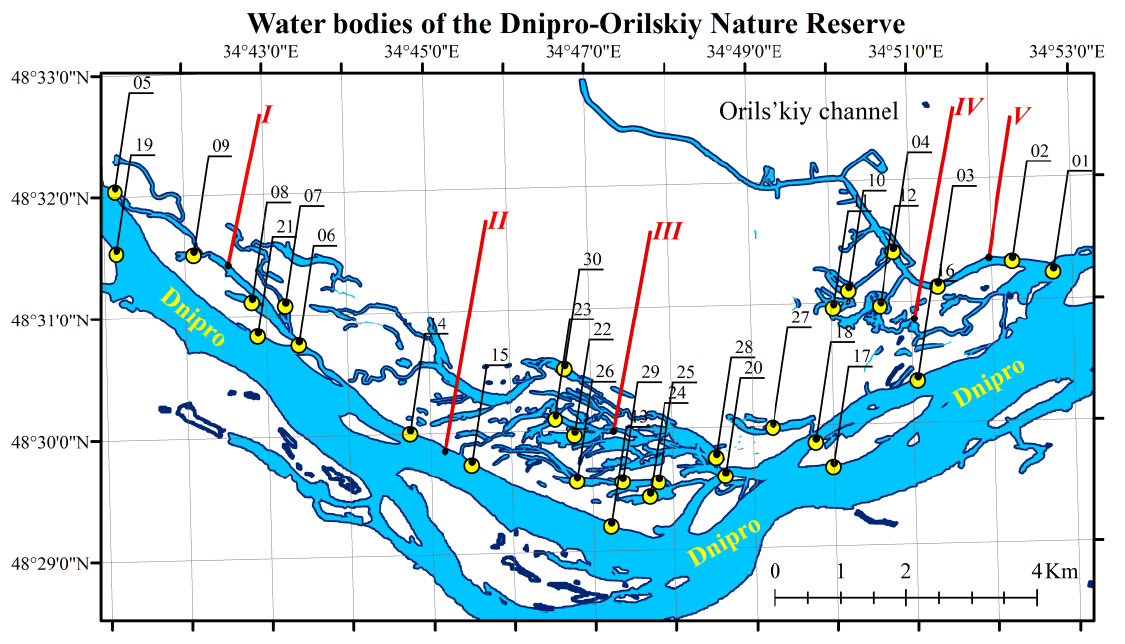
Figure 1. Main groups of water bodies and the location of fish sampling points. I is the